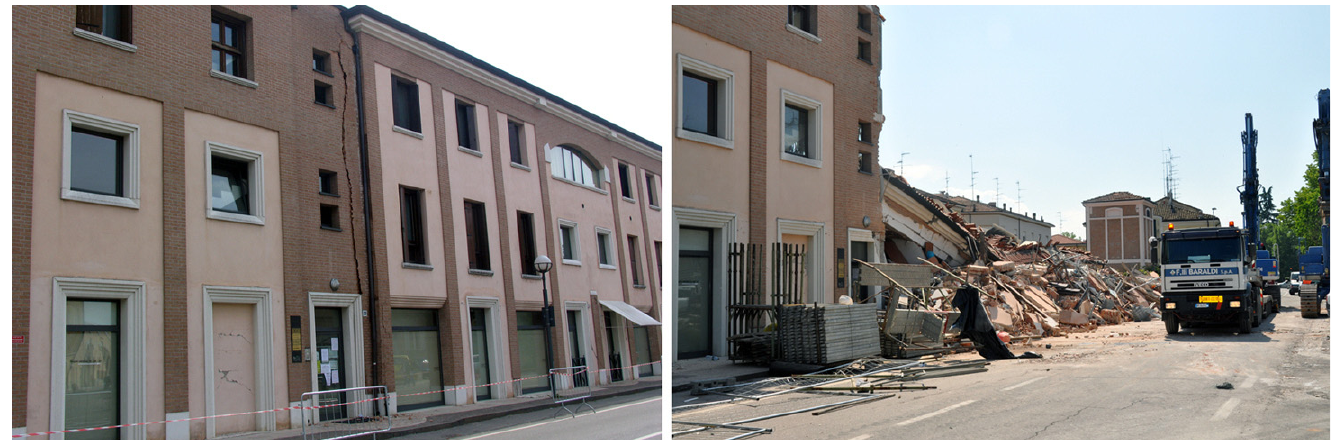
Figure 4. Increase in the damage to reinforced-concrete buildings, for May 20, 2012 (left), and May 29, 2012 (right), in